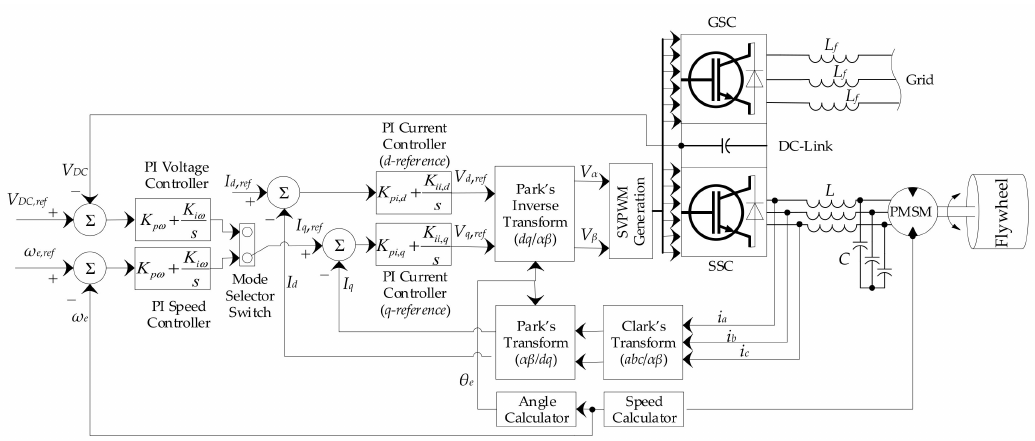
Figure 6. Block diagram of the FESS controlling